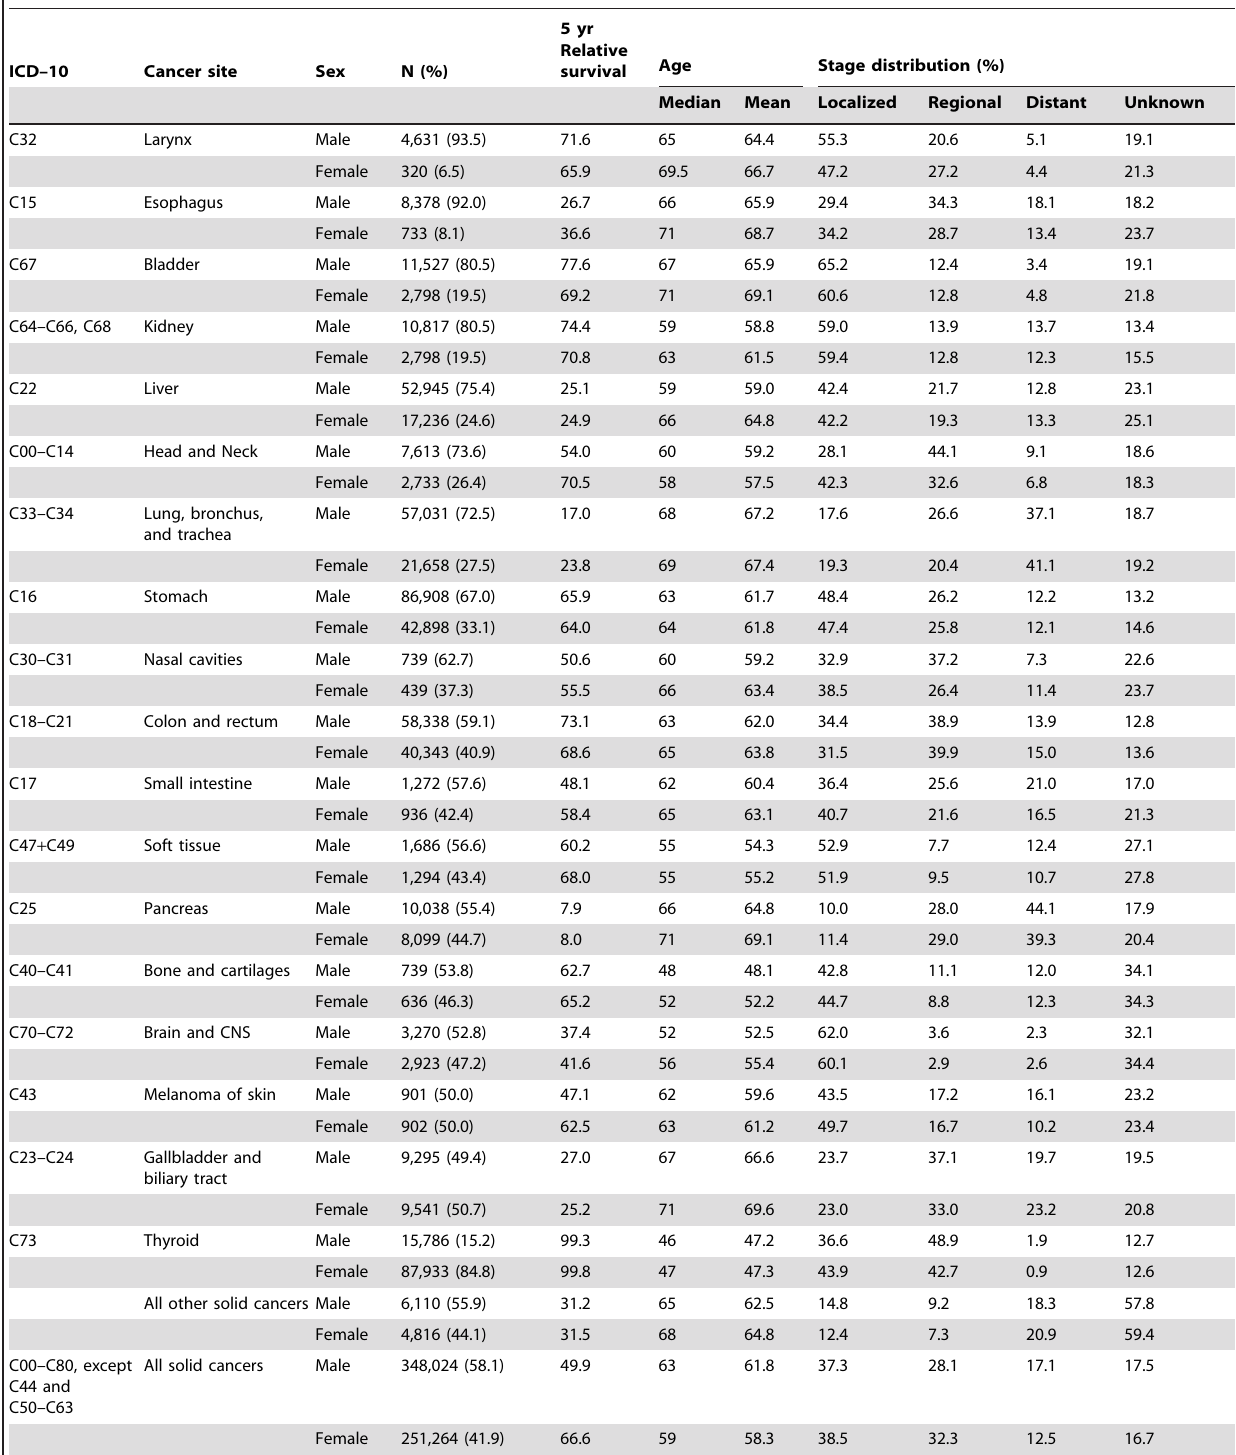
(Table 3). When the analysis was restricted to older patients (older 75 years), women displayed a lower RER than did men only for head/neck, nasal cavity, and lung cancers. Conversely, men